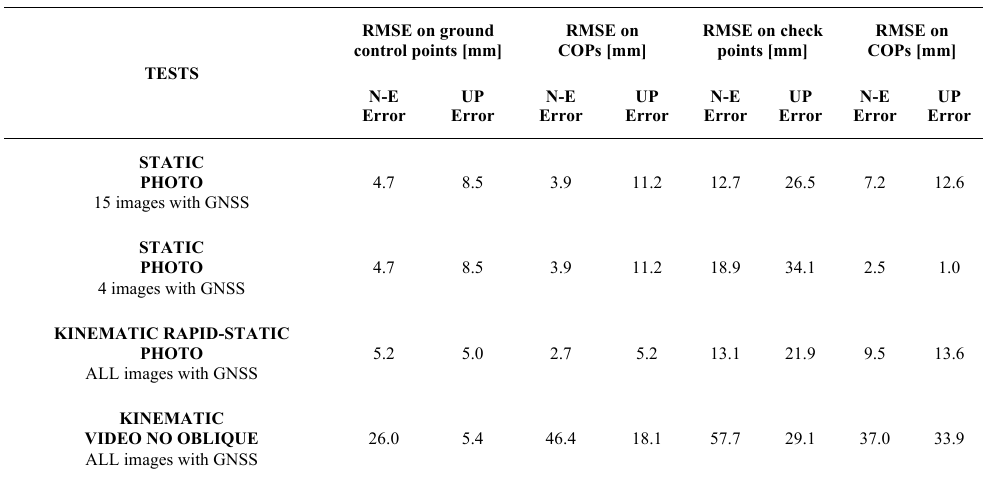
Table 1: RMSEs on the check points/ground control points and on the COPs, both at calibration and survey time.